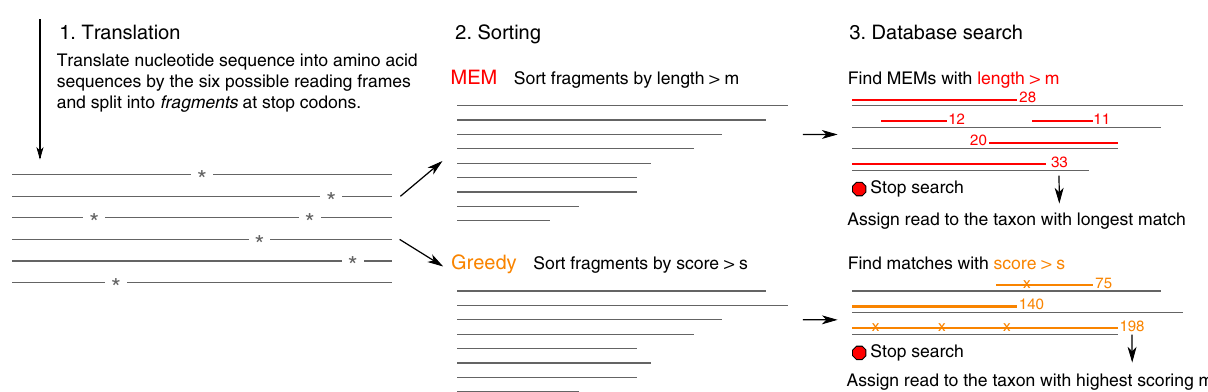
Figure 5 | Kaiju’s algorithm. First, a sequencing read is translated into the six possible reading frames and the resulting amino acid sequences are split into fragments at stop codons. Fragments are then sorted either by their length (MEM mode) or by their BLOSUM62 score (Greedy mode). This sorted list of fragments is then searched against the reference protein database using the backwards search algorithm on the BWT. While MEM mode only allows exact matches, Greedy mode extends matches at their left end by allowing substitutions. Once the remaining fragments in the list are shorter than the best match obtained so far (MEM) or cannot achieve a better score (Greedy), the search stops and the taxon identifier of the corresponding database sequence is